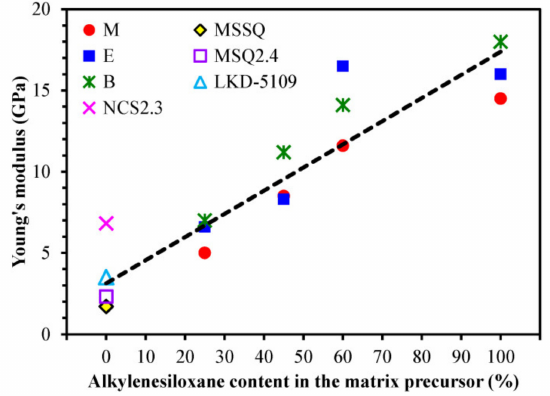
Figure 6. Change of Young’s modulus (YM) versus alkylenesiloxane content in the matrix precursor. The YM of porous organosilicate glass low- k films with only terminal carbon groups are represented by the methylsilsesquioxane (MSSQ) sample ( V = 39%). The YM values reported for well-known low- k films with similar porosity: MSQ2.4 ( V = 42%) [37], LKD-5109 ( V = 39%) [38] and NCS2.3 ( V = 33%) [37] are included for comparison. In this Figure: M—methylene bridge (BTESM), E—ethylene bridge (BTMSE), B—1,4-phenylene bridge